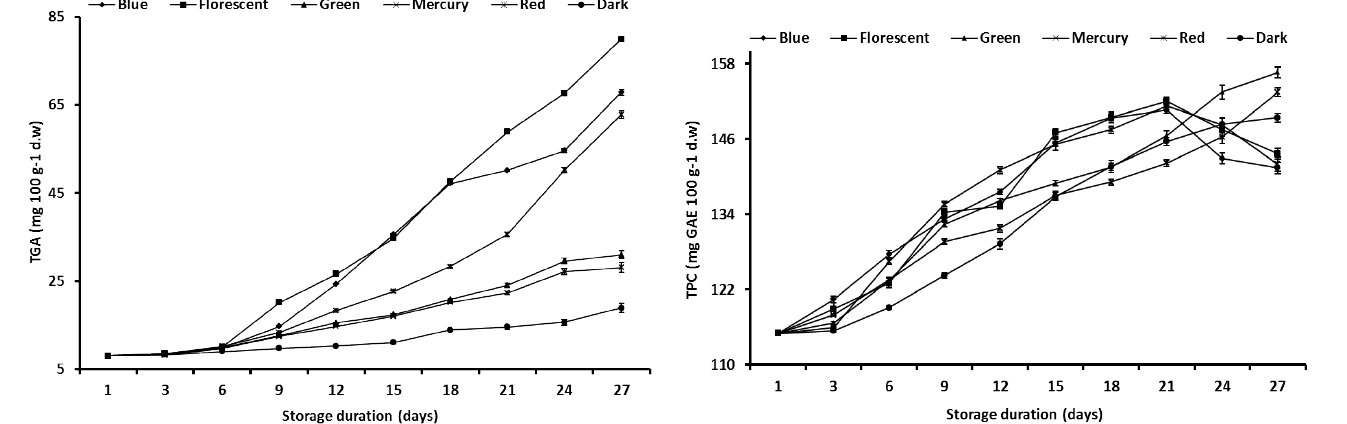
Fig. 6: Effect of different light sources on total glycoalkaloids. Vertical bars show ±SE of means (n=3). The interaction between storage du- ration and light sources was significantly different at p ≤ 0.05.